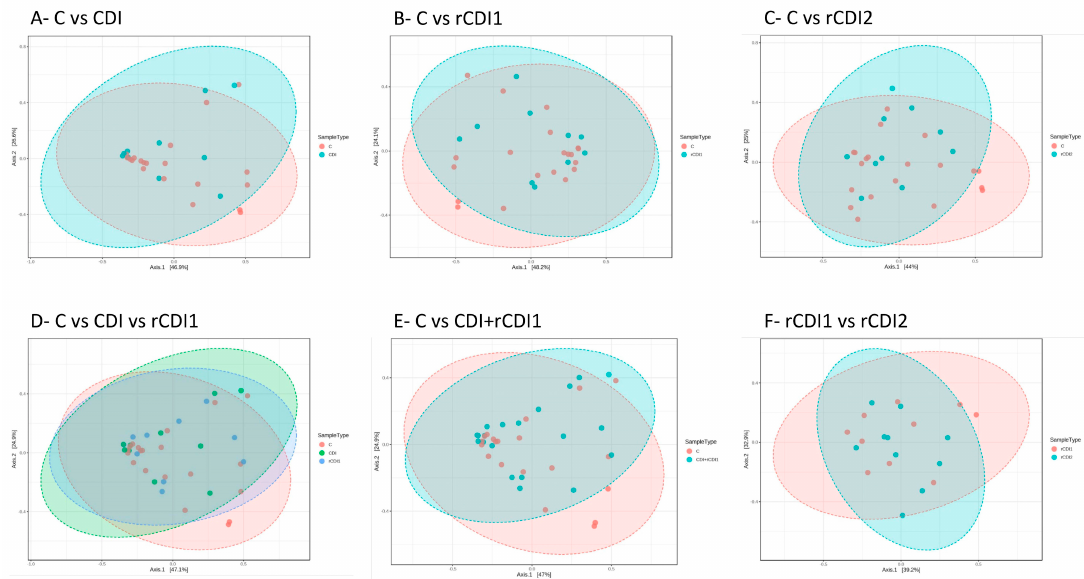
Figure 4. β -diversity. The microbiota distances were evaluated through the Bray–Curtis dissimilarity matrix at the taxonomic level of classes and visualized through Principal Coordinates Analysis (PCoA). Each point represents the microbiota composition of one sample. Abbreviations for patient cohorts: C = non-infected controls; CDI = non-recurrent C. difficile infection; rCDI1 = recurrent C. difficile infection, first episode; rCDI2 = recurrent C. difficile infection, second episode.